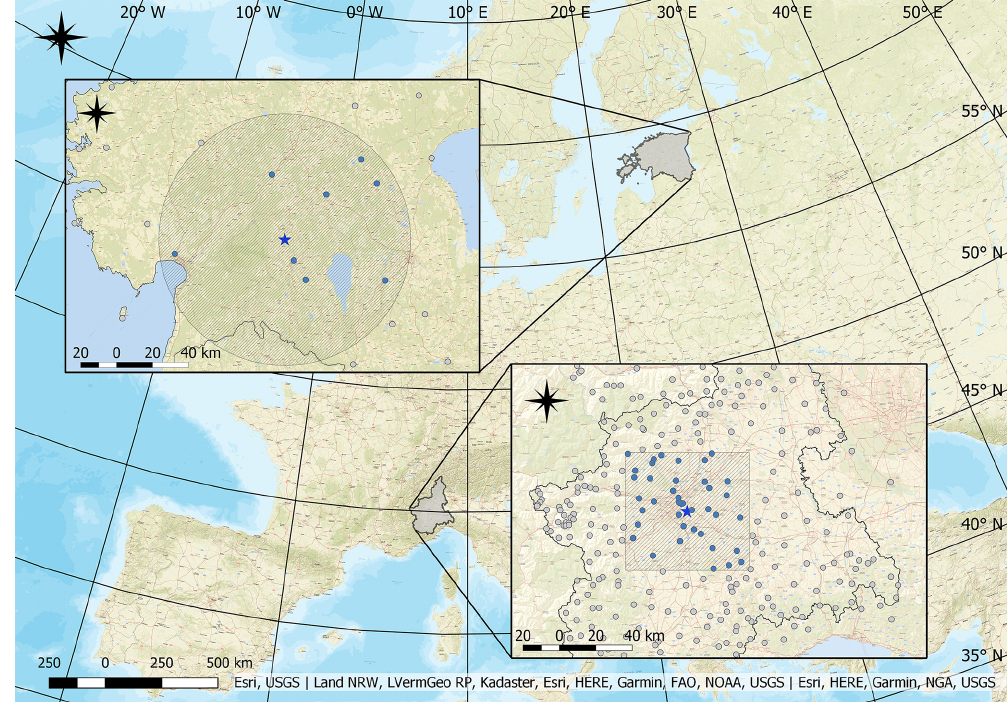
Figure 1. Study areas (shaded) located in Estonia (upper left zoomed-in area) and in Piemonte, Italy (lower right zoomed-in area). Grey dots denote gauge locations of both the Estonian and Piemonte region and blue dots gauges inside the study area. Blue stars reveal radar